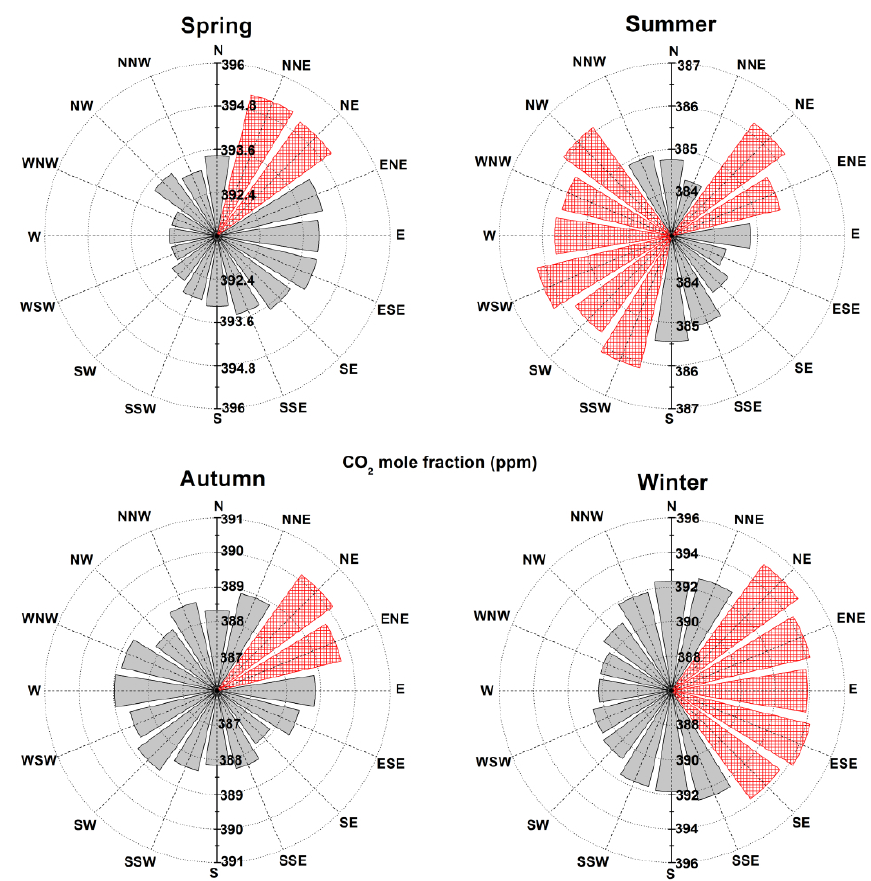
Fig. 5. Seasonal hourly CO 2 mole fractions on 16 horizontal wind directions at WLG. The light-grey bars denote CO 2 mole fractions from wind sectors considered to be background representative, while the red hatched bars denote CO 2 mole fractions that are likely to be influenced by local/regional